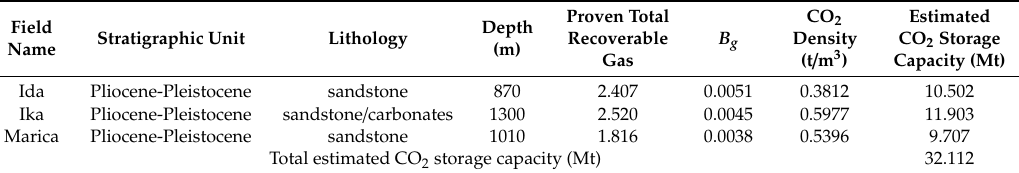
Table 1. Summary of parameters used for CO 2 storage capacity estimation of the Northern Adriatic gas-fields.